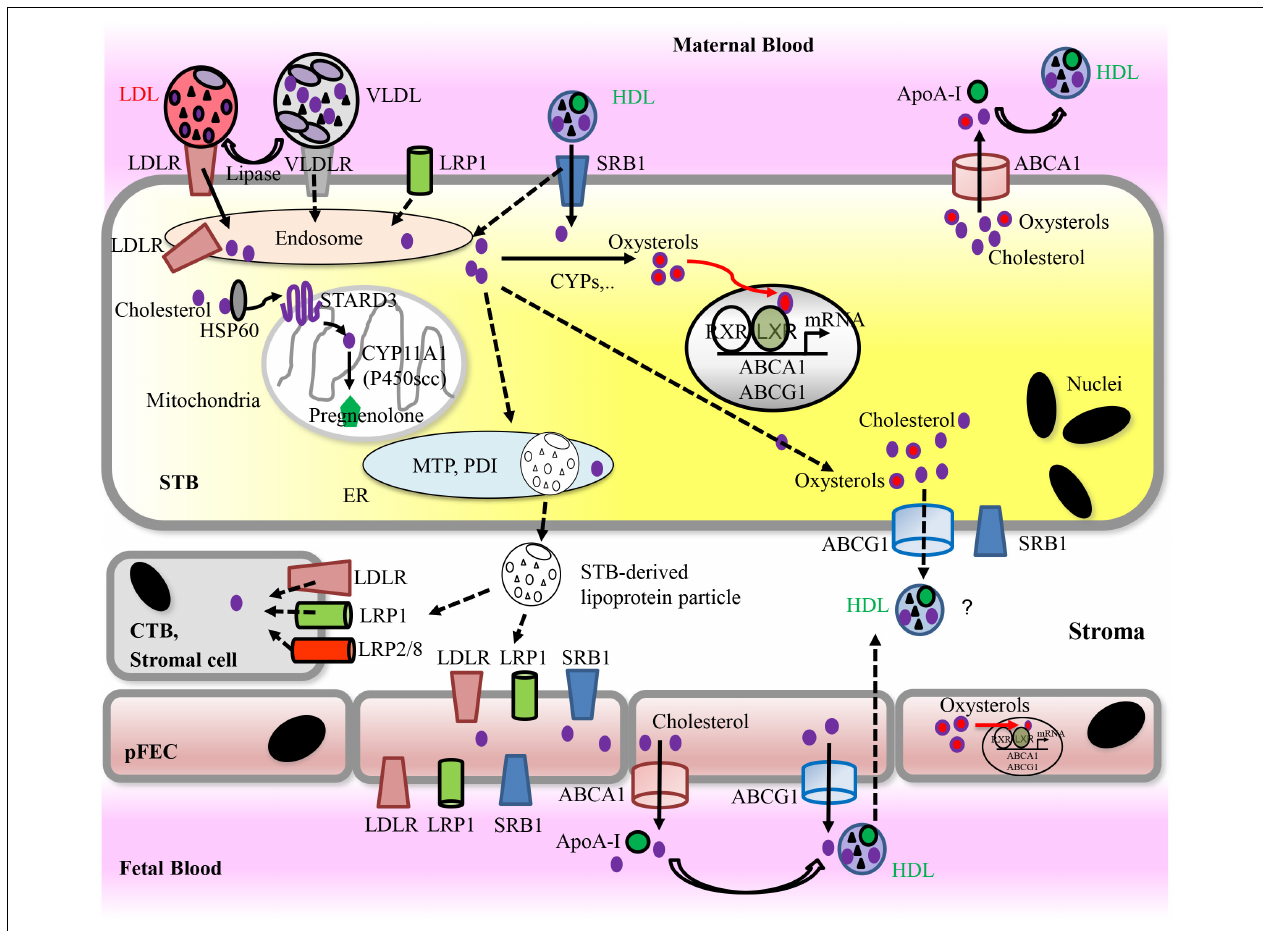
FIGURE 4 | Proposed model for placental uptake of cholesterol from maternal lipoproteins, cholesterol metabolism, and materno-fetal transport of cholesterol. For detailed information, see text. Solid arrows indicate pathways that have been demonstrated in vitro . Dashed arrows indicate hypothetic routes. Apo, Apolipoprotein; ABC transporters, ATP-binding cassette transporters; CYPs, cytochrome P-450 enzymes; CTB, cytotrophoblast; pFECs, placental-fetal endothelial cells; HDL, high-density lipoprotein; HSP, heat shock protein; LDL, low-density lipoprotein; LDLR, low-density lipoprotein receptor; LRP, lipoprotein receptor-related proteins; LXR, liver X receptor; PDI, protein disulfide isomerase; MTP, microsomal triglyceride transfer protein; RXR, retinoid X receptor; SRB1, scavenger receptor class B type 1; STARD3, StAR-related lipid transfer domain protein 3; STB, syncytiotrophoblast; VLDL, very low-density lipoprotein; VLDLR, very low-density lipoprotein